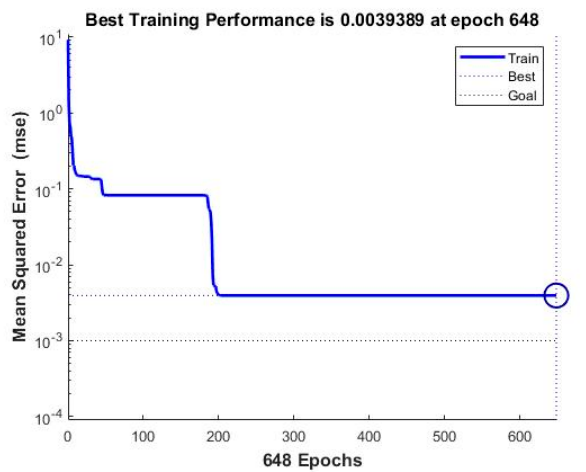
Figure 15. The number of iterations of the GA-BP algorithm.